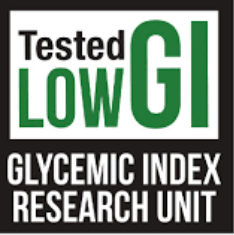
Figure 4. Temasek Polytechnic’s low GI tested logo.